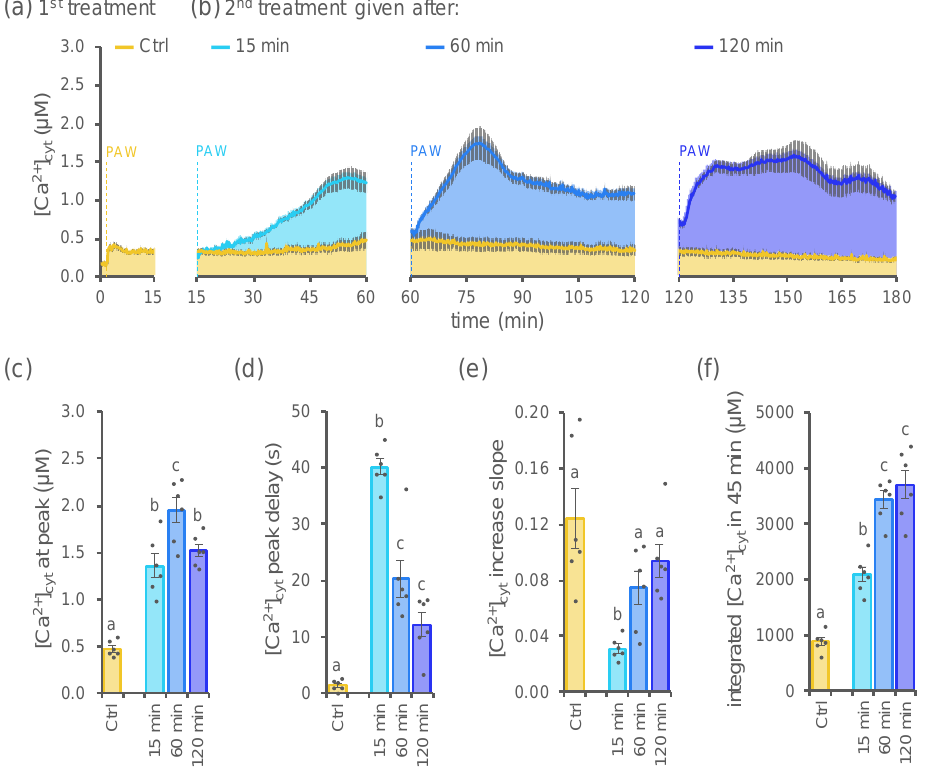
Figure 4. Subsequent administration of DBD-PAW to Arabidopsis seedlings triggered a modified Ca 2+ signature, depending on the resting time between the two treatments. Elevations in [Ca 2+ ] cyt were measured in aequorin-expressing Arabidopsis seedlings after the administration (at 100 s, yellow dashed line) of a 1:2 dilution of DBD-PAW ( a ). A second equivalent dose of DBD-PAW was administered (dashed lines) at different times ( b ): 15 min (light blue), 60 min (blue) and 120 min (dark blue). All DBD-PAWs were obtained by exposing deionized H 2 O to cold plasma for 3 min, with the DBD’s discharge frequency set at 20 kHz. ( a , b ) Data are the means (solid lines) ± SE (shadings) of the evoked [Ca 2+ ] cyt dynamics in 6 independent seedlings. Control seedlings (Ctrl) were subjected to only one DBD-PAW treatment. ( c – f ) Statistical analyses of the [Ca 2+ ] cyt peak ( c ), the temporal delay in the onset of the [Ca 2+ ] cyt peak ( d ), the slope of the [Ca 2+ ] cyt increase ( e ) and the integrated [Ca 2+ ] cyt dynamics over 45 min ( f ). Each dot represents a single biological replicate. Bars labelled with different letters differ significantly (Student’s t -test, p < 0.05).